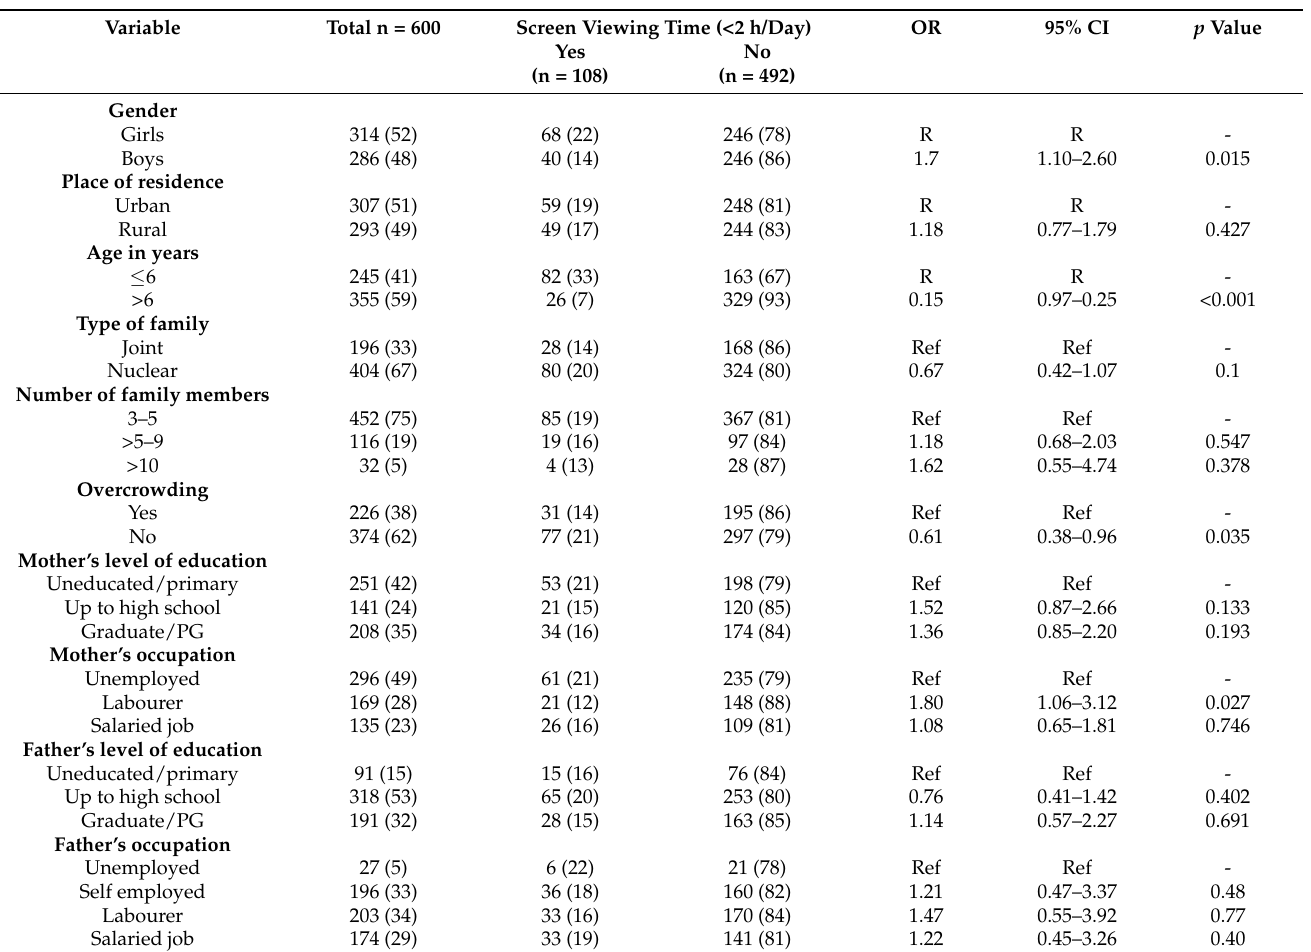
Table 1. Bivariate analysis of sociodemographic factors associated with <2 h/day of screen viewing time in the 600 children included in the study.